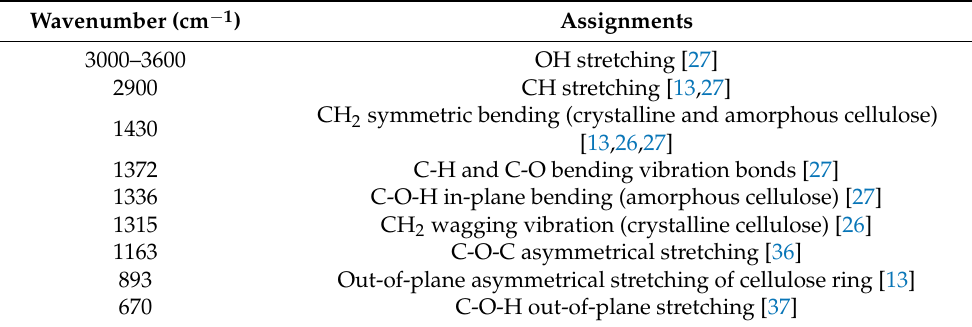
Table 2. Assignment of FTIR absorption bands for the cellulose of Cactaceae